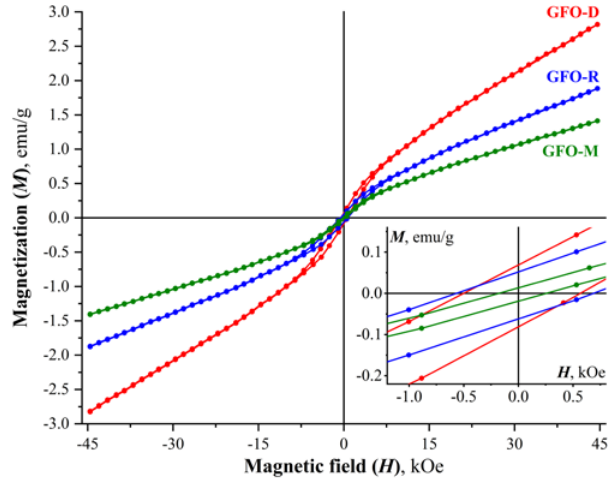
Figure 8. Magnetization curves of the obtained GdFeO 3 samples at 298 K.